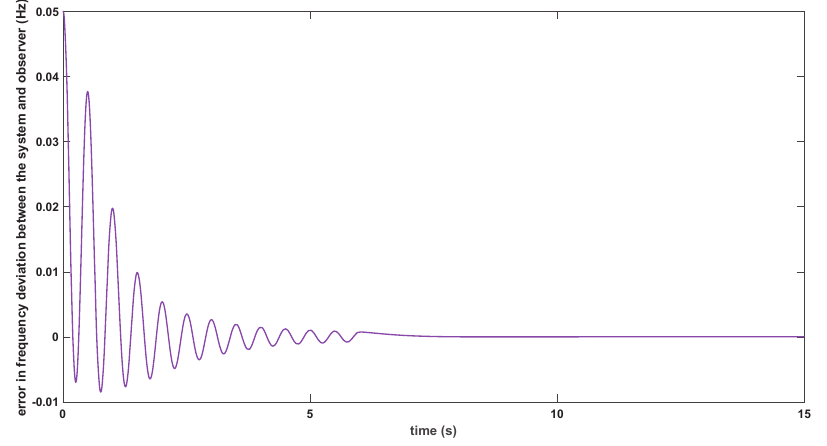
Figure 4. Frequency deviation ∆ f and estimated frequency deviation ˆ ∆ f .